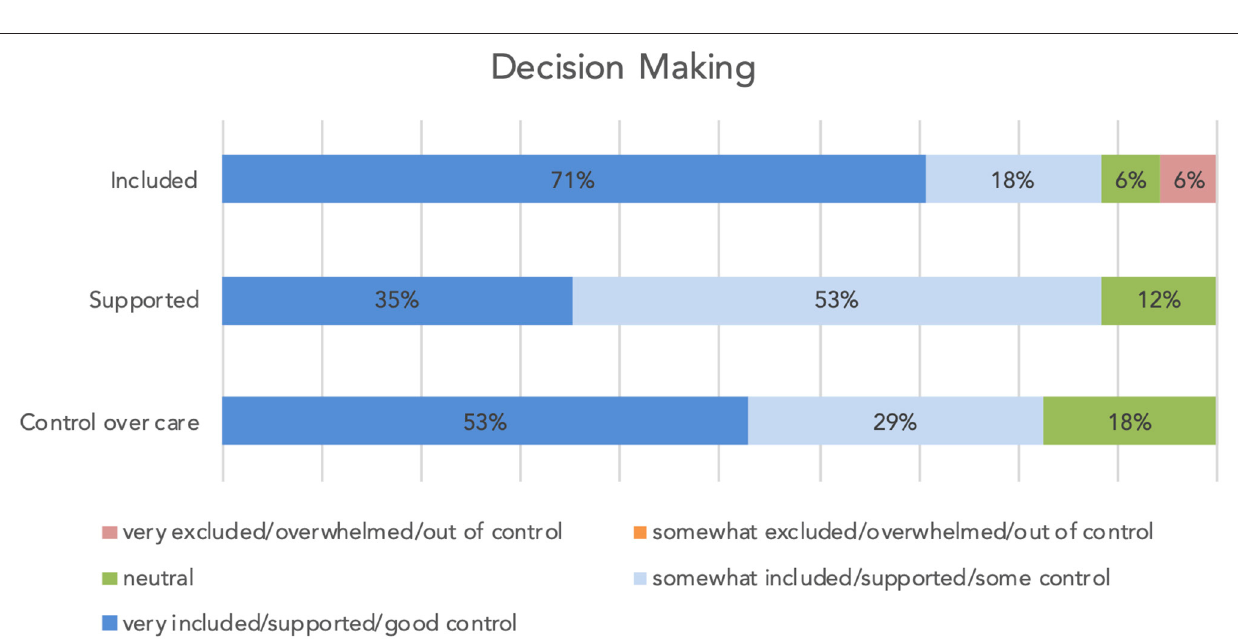
Frontiers in Neurology | www.frontiersin.org